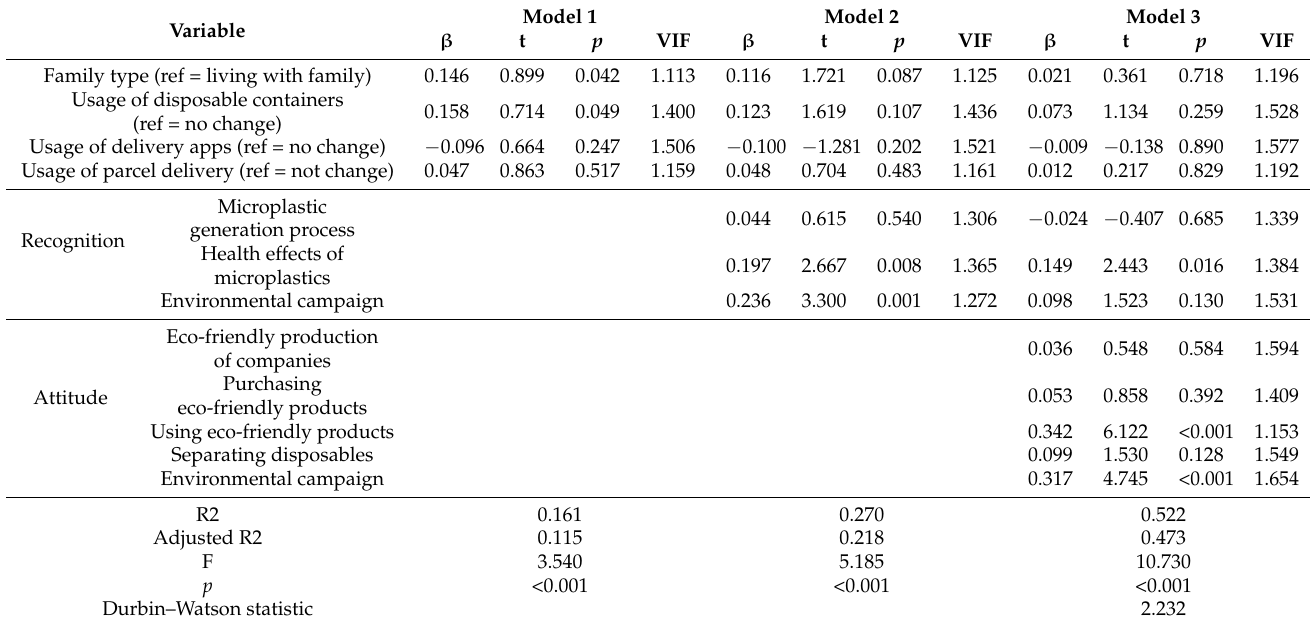
Table 3. Factors influencing zero-waste